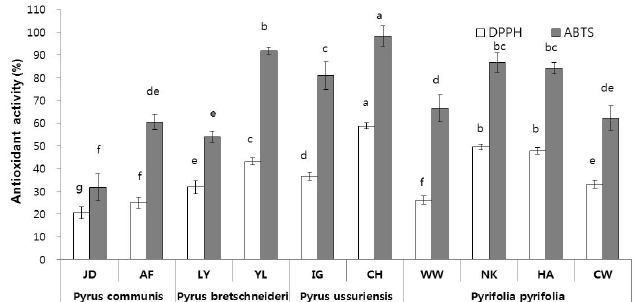
Fig. 2: Antioxidant activities of 10 different pear cultivars according to DPPH and ABTS assays. Value are means ± SD ( n = 3). Different letters (a to g) of each indicate significant difference at P < 0.05 according to DMR test. The cultivars used are Jules d’Airolles (JD), Abate Fetal (AF), Laiyangchili (LY), Yali (YL), Ingyebae (IG), Cheongbae (CH), Wonwhang (WW), Niitaka (NK), Hanareum (HA), and Chuwhang